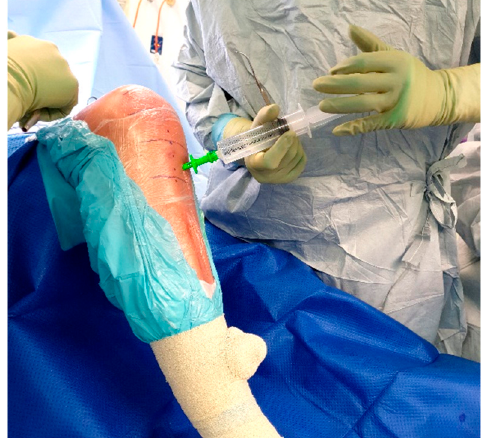
Figure 4. Manual IO insertion.